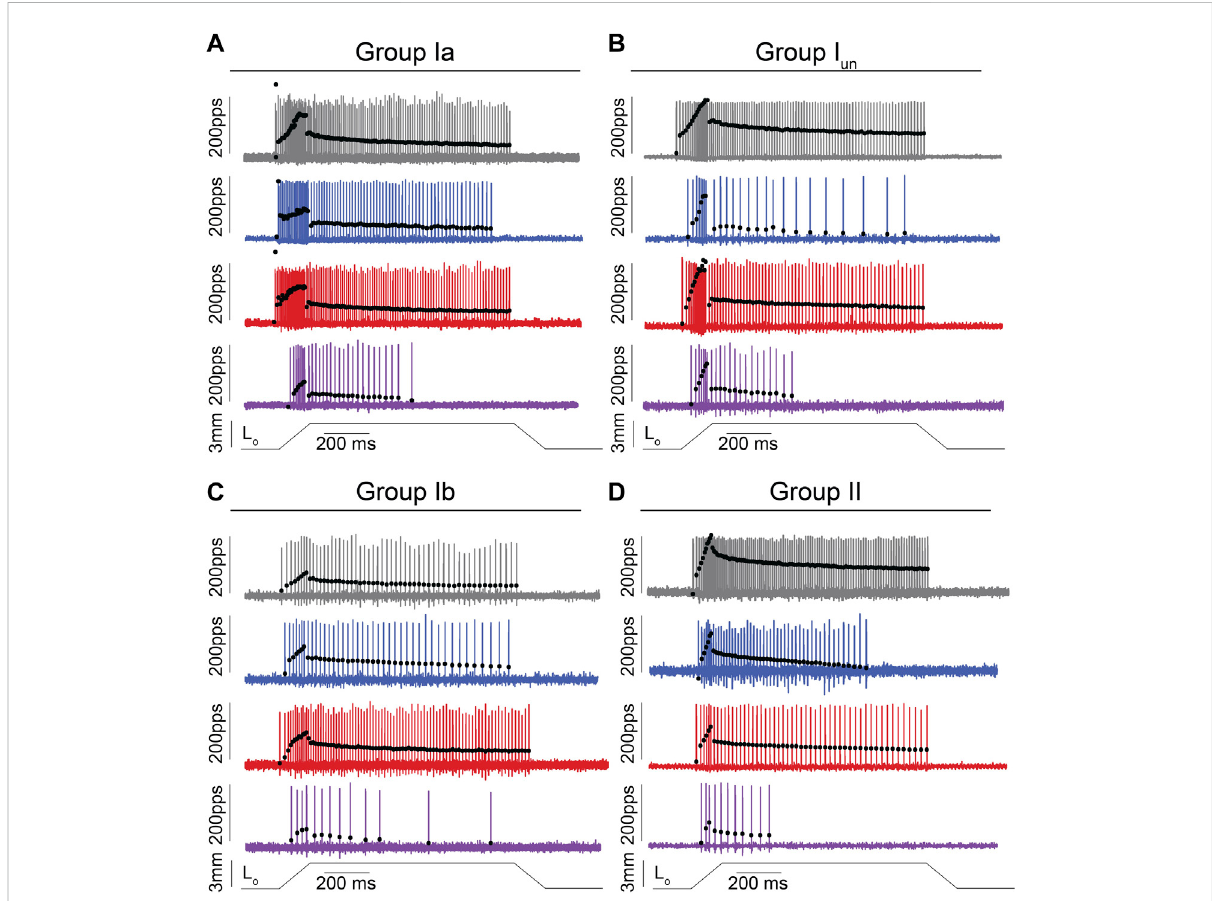
FIGURE 1 Impaired Muscle Mechanosensory Neuron Population Code After Cancer Treatment. (A – D) Representative cases of spiking activity in control (grey), OX(blue),cancer(red),andcOIN (purple)as ameasure ofsensoryencodinginspindlegroup Ia (A) ,unclassi fi edspindle (B) , groupIb (C) , group II (D) . Blackcircles plot instantaneous fi ring rates (IFR) measures as pulses per second (pps) of corresponding spike (action potential: vertical lines) intervals. Dashed vertical line marks onset of muscle stretch [3 mm from resting length (Lo)] shown in bottom trace divided into dynamic and static phases by dark grey (150 ms duration after stretch command onset) and light grey (1 s duration after the dynamic phase)